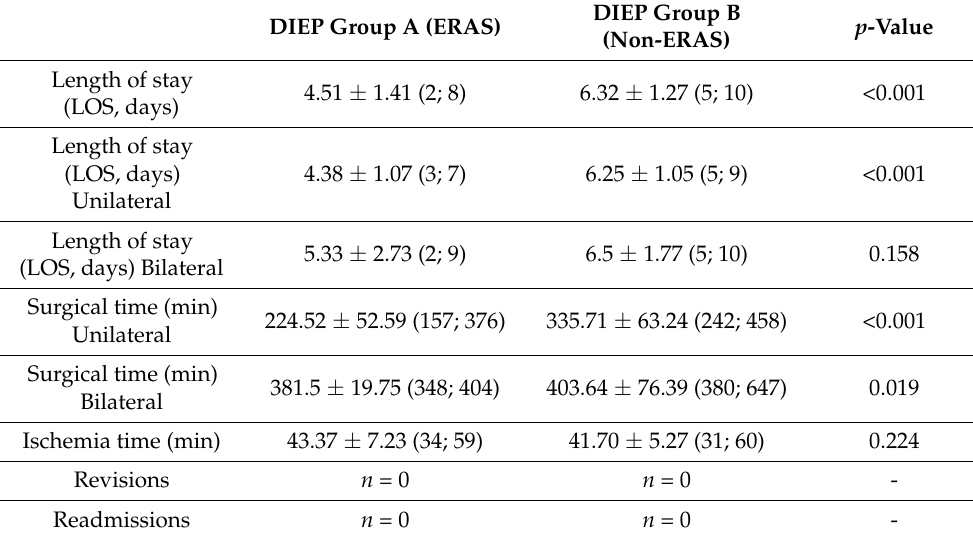
Table 2. Intra- and postoperative results in group A (ERAS) and B (non-ERAS) including length of stay, surgical time, ischemia time, coupler size, revisions of the 79 patients available for personal follow-up. Values are given as mean ± SD [95% confidence interval] or (minimum;